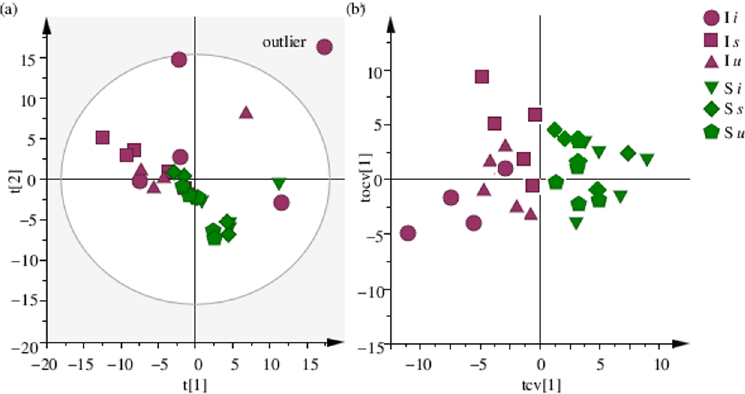
Fig 2. PCA and OPLS-DA score plot. (a) Principalcomponentanalysis(PCA) score plot of 1H NMR spectra of all six treatments, with component1 showing38.9% and component2 showing25.4% of the variationand (b) the corresponding cross-validated OPLS-DA score plot after removalof the outlier.